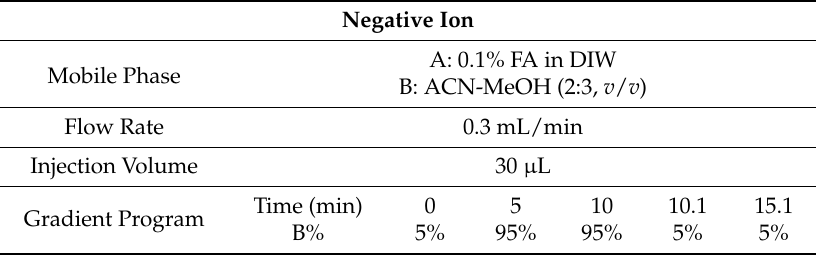
Table 5. Chromatographic separation of hydrochlorothiazide and its by-products for NI